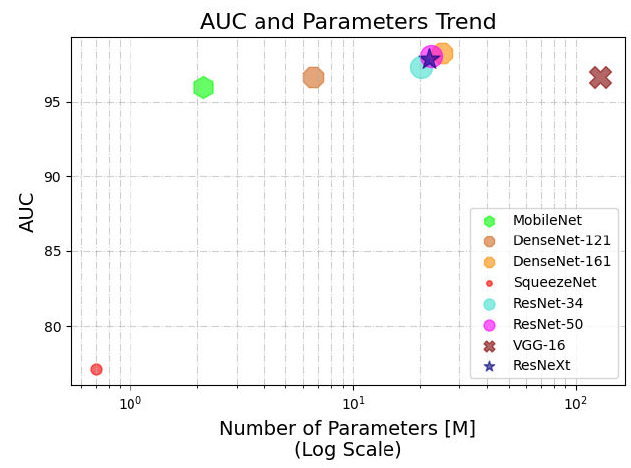
Figure 8. The relationship between area under the curve and number of trainable parameters for the eight CNN architectures considered throughout this